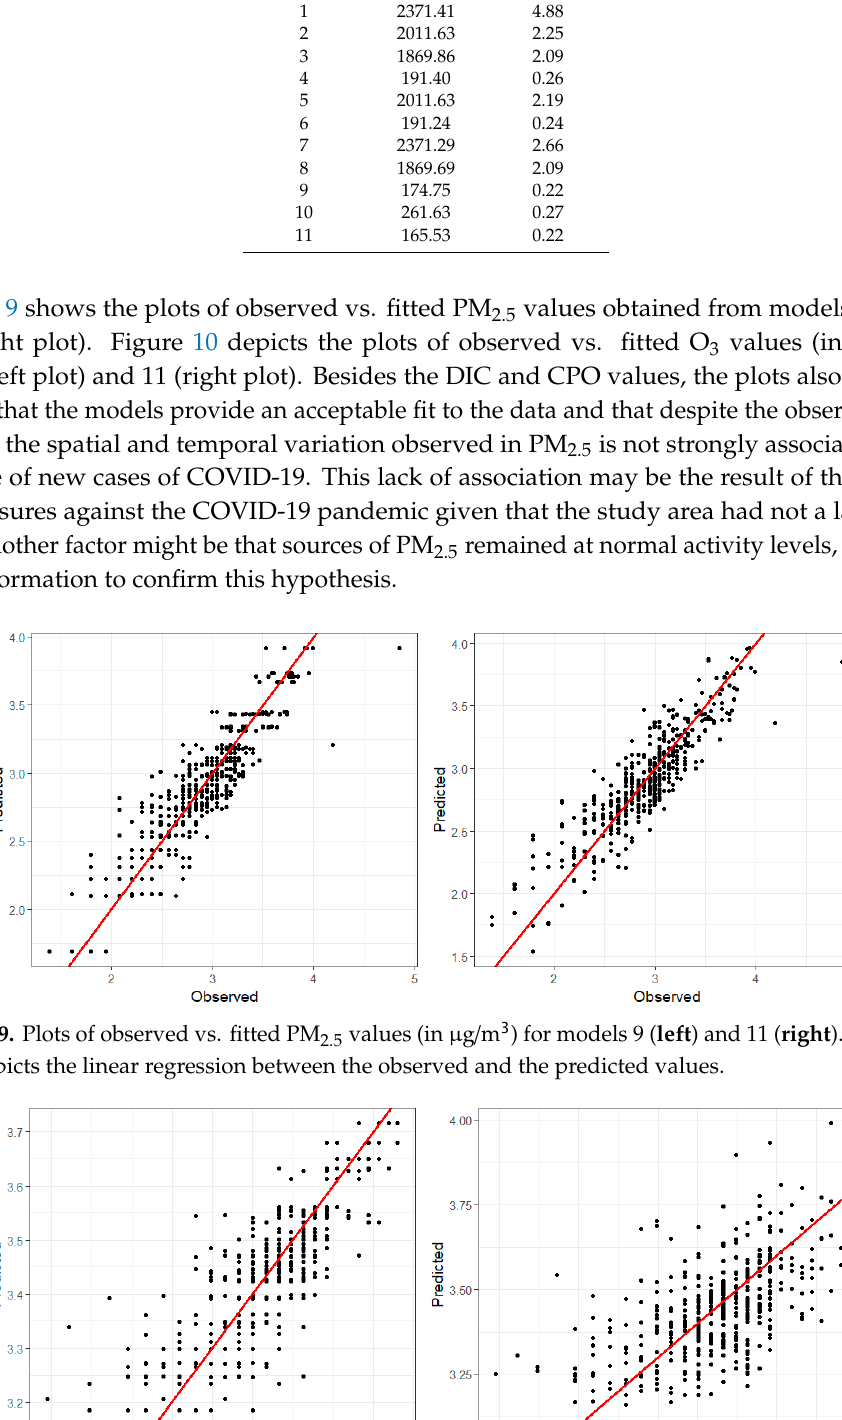
Table 4. Deviance information criterion (DIC) and conditional predictive ordinate (CPO) of models (for O 3 ).